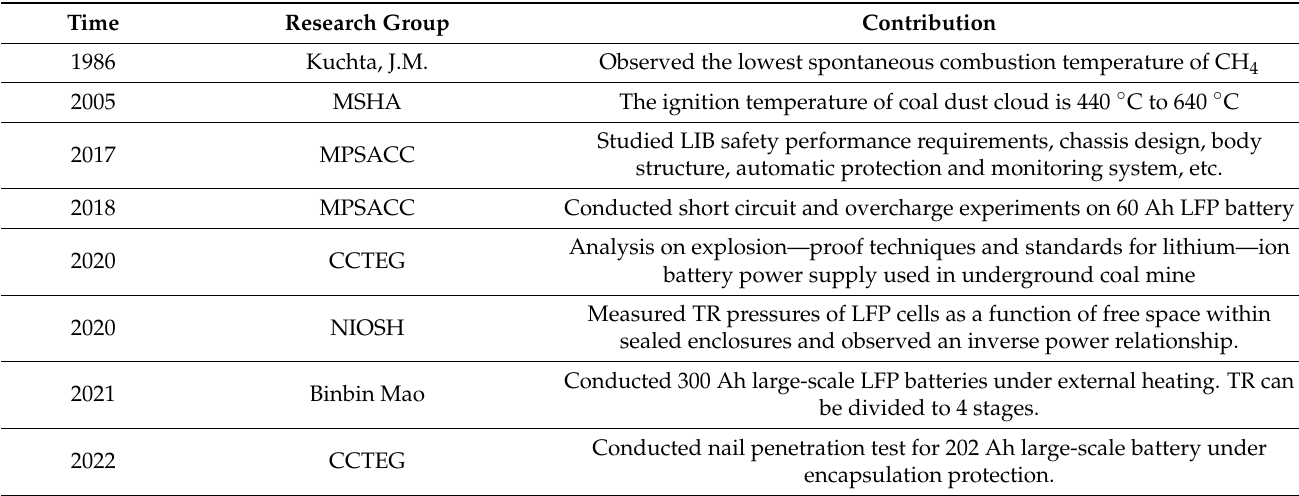
Table 6. Recent progress of large-scale LIB applications in mining industry [8,105–111].